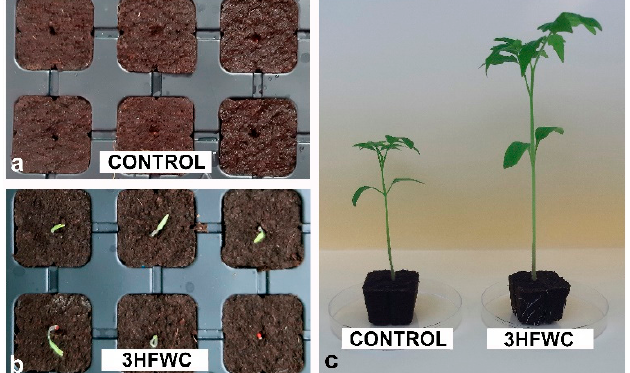
Figure 2. The effect of 3HFWC nanosubstance on cherry tomato seed germination: ( a , b ) growth containers with control seeds; ( a ) 3HFWC nanosubstance-treated seeds; ( b ) after three days of growth; and ( c ) cherry tomato seedlings after three weeks of growth.